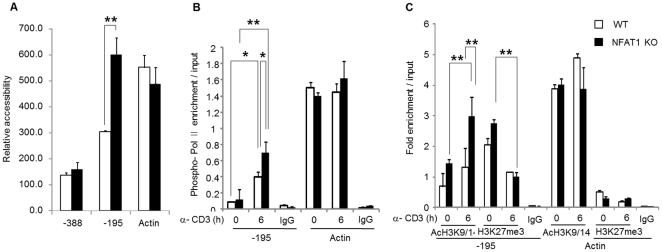
NFAT1 deficient Th2 cells have more permissive chromatin structure at the IL-4 promoter.(A) For chromatin accessibility analysis, Th2 cells differentiated in vitro from WT or NFAT1 KO mice were stimulated with anti-CD3 for 6 h. Nuclei isolated from each group and were incubated with or without 50 U Mnase. Fifty nanograms of genomic DNA from each treatment were subjected to real-time PCR analysis with indicated primer sets covering IL-4 promoter. The Ct values generated were converted to DNA concentrations by using the standard curve. MNase accessibility was expressed as a relative value of undigested genomic DNA and plotted for each primer set. Graphs depict the PCR products from digested samples normalized to the PCR products from undigested samples and show mean ± SEM, n = 3 and ** P<0.01 for four separate experiments. To measure the mounts of recruited Pol II and modified histone molecules at the IL-4 promoter, ChIP analysis was performed with antibodies specific for RNA Pol II (B) and acetyl histone H3 lysine 9/14 (AcH3K9/14), trimethyl histoneH3 lysine 27 (H3K27me3) or isotype matched control IgG (C). Relative amount of enriched DNA by ChIP was measured by quantitative RT-PCR using the primers spanning the indicated IL-4 promoter region or β-actin region. The graph represents mean ± SEM, from four separate experiments and * P<0.05, ** P<0.01.